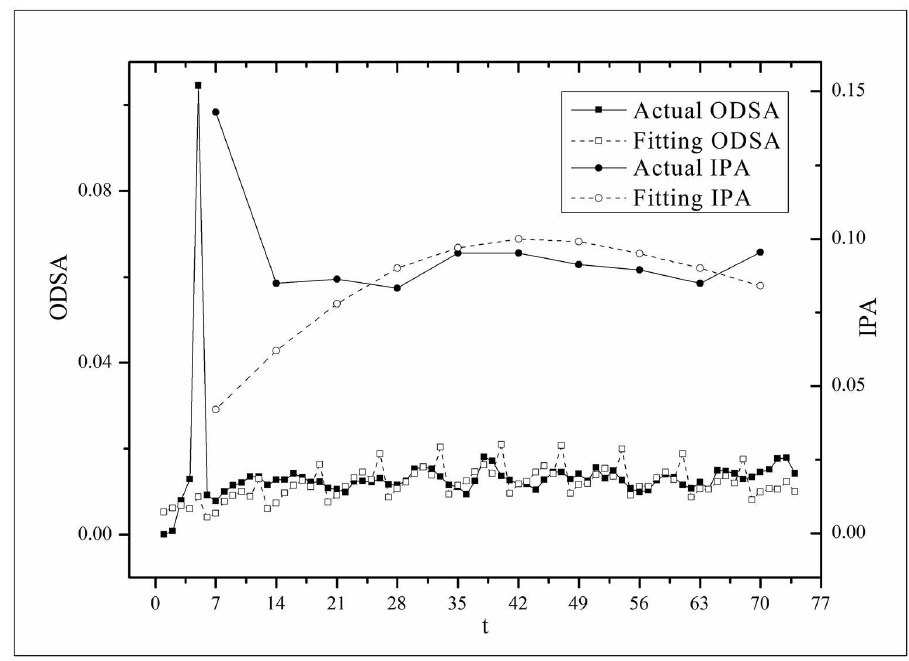
Fig 8. Two-step fitting results for the Farmer dataset.